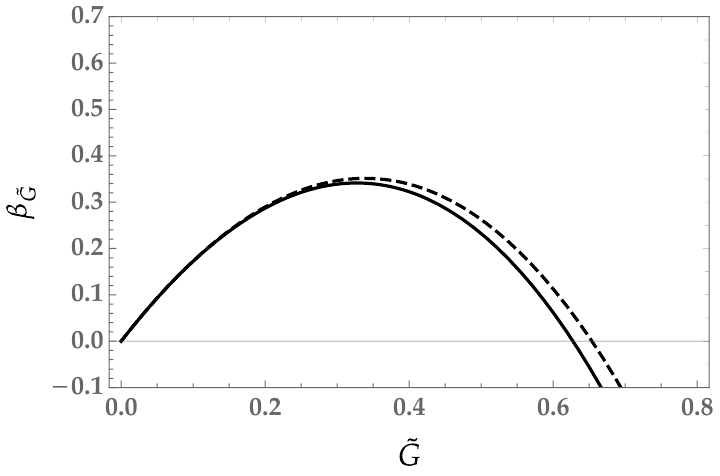
Figure 1. The beta function for Newton’s constant in the Einstein–Hilbert approximation (dashed line) and the order ∂ 4 approximation (solid